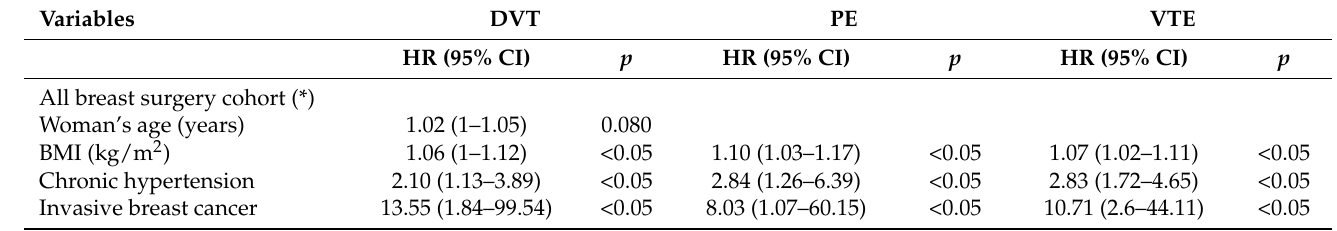
Table 3. The table shows the factors associated with a new diagnosis of deep vein thrombosis